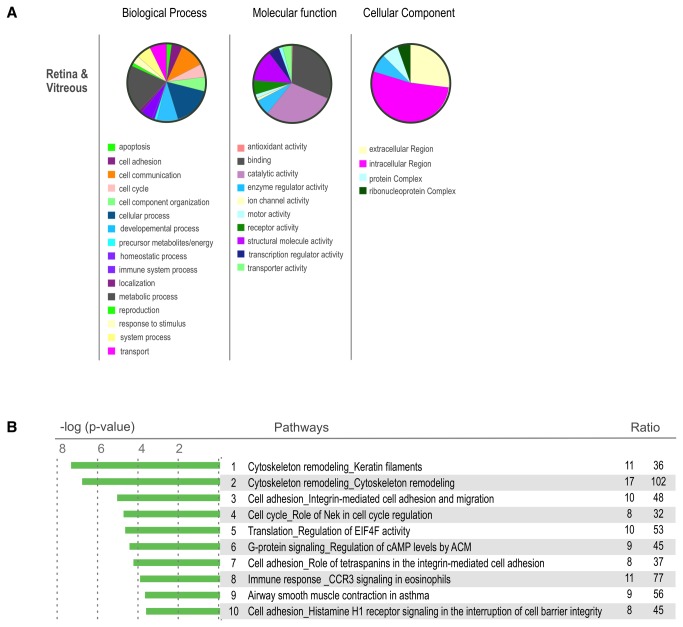
Proteins expressed similarly in the Retina and Vitreous.
A. Gene Ontology distribution of proteins identified in both the mouse vitreous and retina. Proteins are grouped into sub-categories of (A.) biological processes, (B.) cellular component, and (C.) molecular processes. B. Top 50 pathways represented by the similar proteins (p >= 0.05).